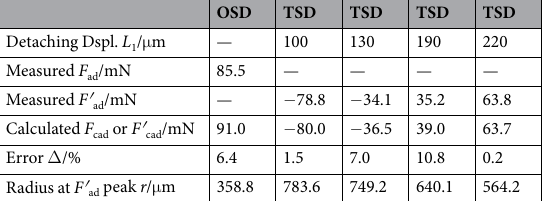
Table 1. F ′ ad (or F ad ) and F ′ cad (or F cad ) for the PDMS sphere of diameter 11.1 mm with the detaching velocity of 313 μ m/s and a loading displacement 200 μ